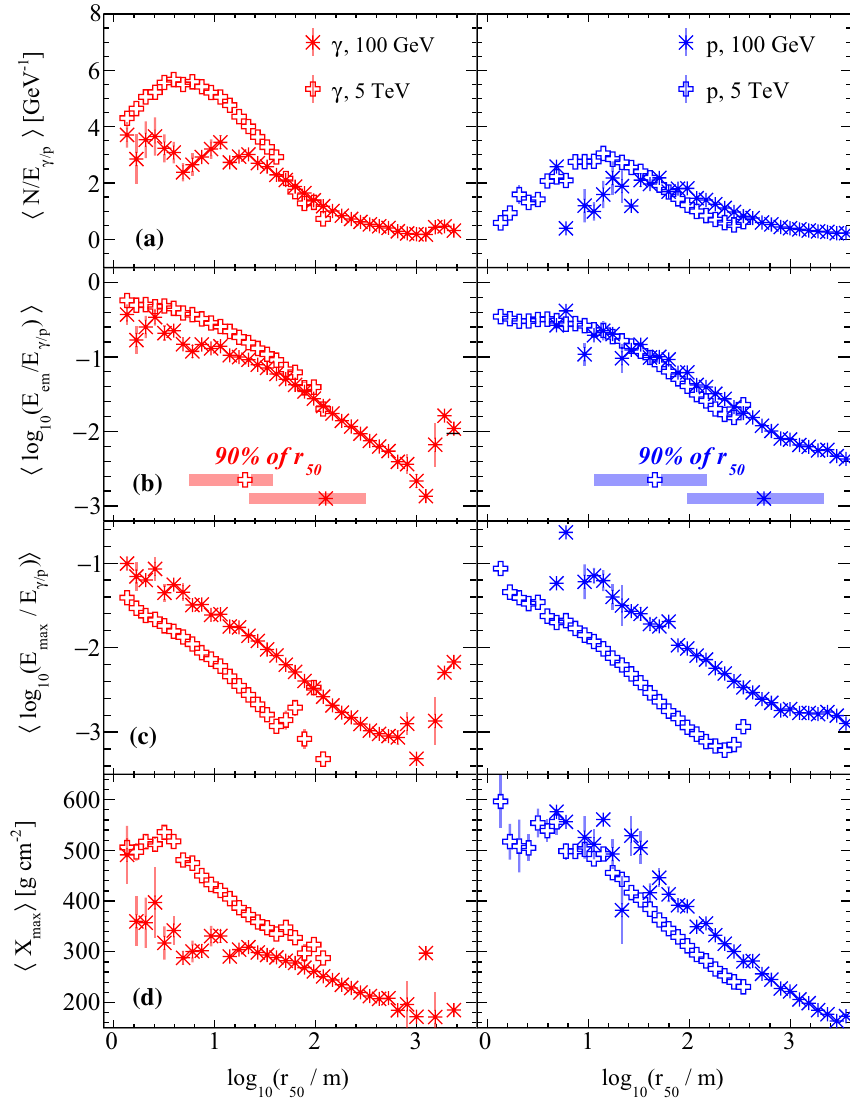
Fig. 8 Relationship of the lateral extent parameter r 50 to other shower parameters for vertical EAS observed at 5 km altitude. Results are shown for γ -ray (left panels) and proton (right panels) primary particles simulated at two different energies. From top to bottom the following EAS parameters are shown: a The average number of particles at ground with energy of more than 1 MeV. b Average EM energy at ground. In addition, the bands on this panel indicate the range that contains 90% of r 50 values. c The maximum energy of a single EM-particle ( e ± ,γ ). d Depth of shower maximum, obtained from the fit routine within CORSIKA. The parameters shown in a – c are scaled with the energy of the primary